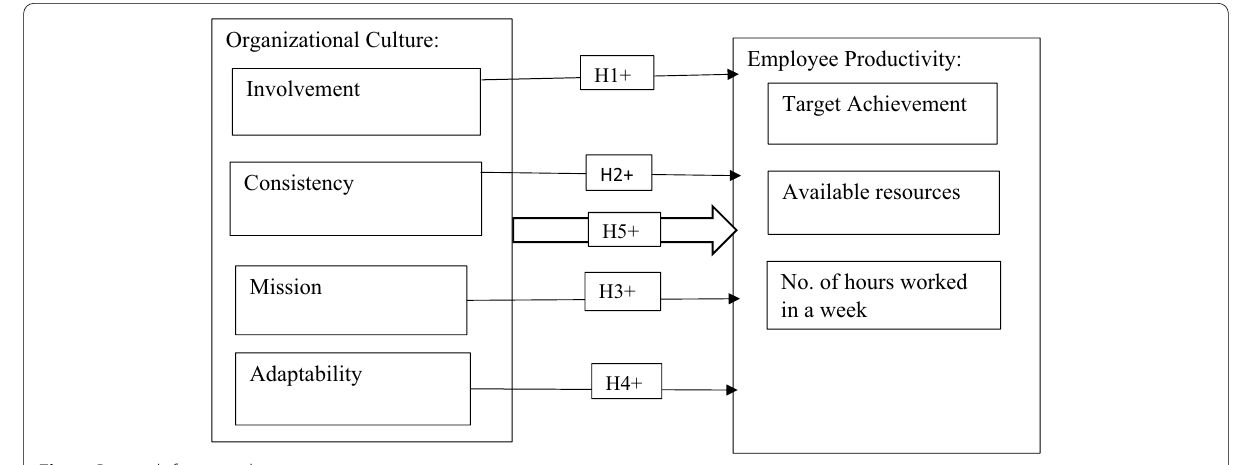
Fig. 1 Research framework